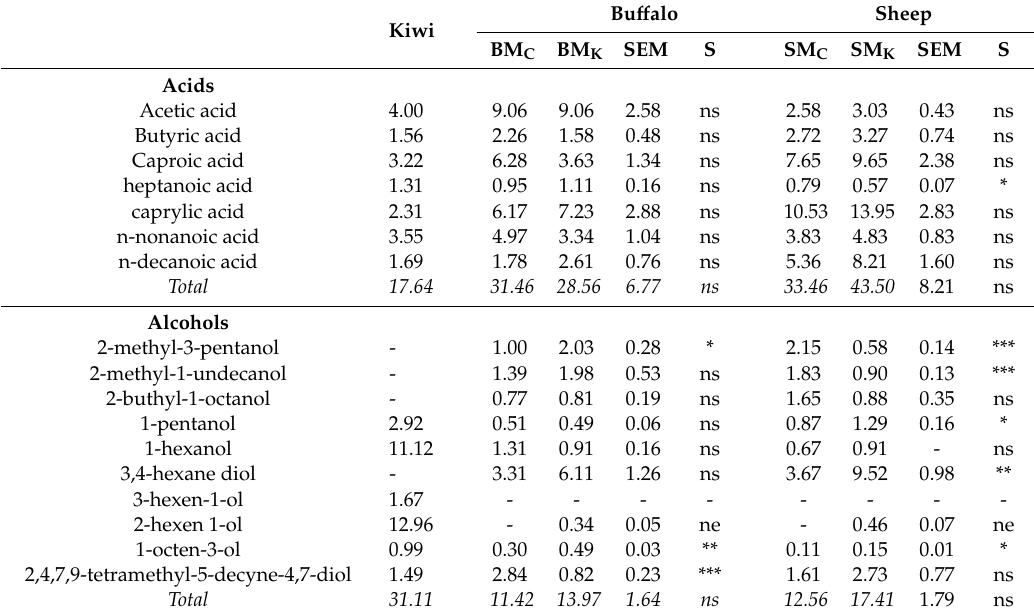
Table 4. Volatile organic compounds of cheeses made with kiwifruit extract or calf rennet ( µ g / kg of raw matter) (Part